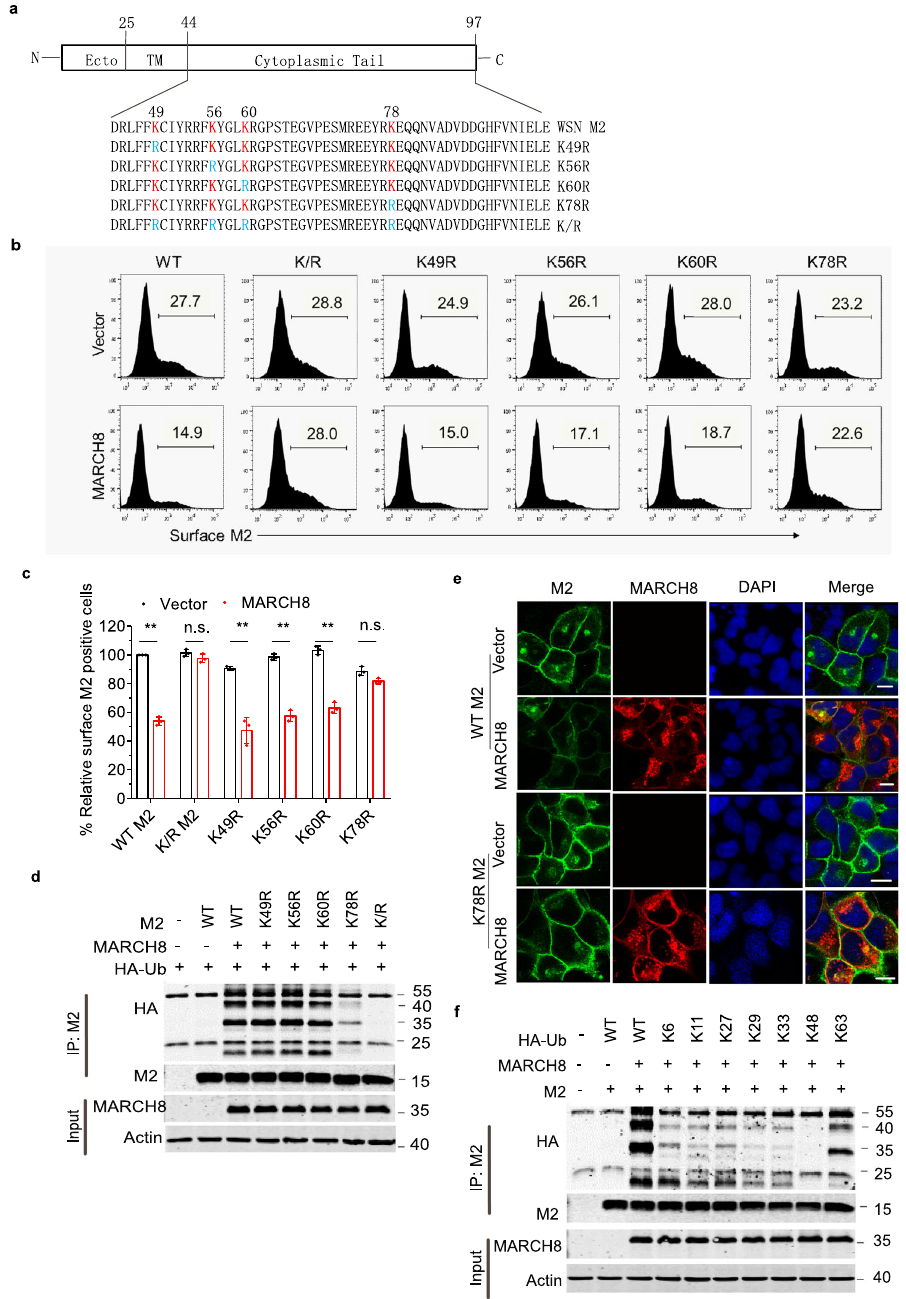
Fig. 6 MARCH8 mediates K63-linked polyubiquitination of M2 at position K78. a Illustration of IAV M2 domain-organization and the cytoplasmic tail amino-acid sequence of WSN virus M2 and the indicated mutants. Lysine residues (K) are marked as red, and the K>R mutants are marked as blue. b , c HEK293T cells were transfected with M2 mutants and vector or MARCH8. Surface M2 was determined by fl ow cytometry ( b ). Quantitation of M2 positive cells was shown in ( c ). Data shown are the means±SD ( n = 3 biological replicates). ** P <0.001; n.s., nonsigni fi cant, unpaired two-tailed Student t -test, without any adjustments for multiple comparisons. d Ubiquitination of M2 mutants by MARCH8. HEK293T cells were transfected with M2 mutants and vector or MARCH8. Cell lysates were subject to IP with anti-M2 antibody, and the IP and input were analyzed by western blotting with antibodies against the indicated targets. e HeLa cells were co-transfected with WT or the K78R mutant M2 and vector or MARCH8. M2 and MARCH8 were detected with speci fi c antibodies in confocal microscopy. Scale bars represent 10 µ m. f HEK293T cells were transfected with HA-tagged ubiquitin mutants, M2 and MARCH8. Cell lysates were subject to IP with anti-M2 antibody, and the IP and input were analyzed by western blot with antibodies against the indicated